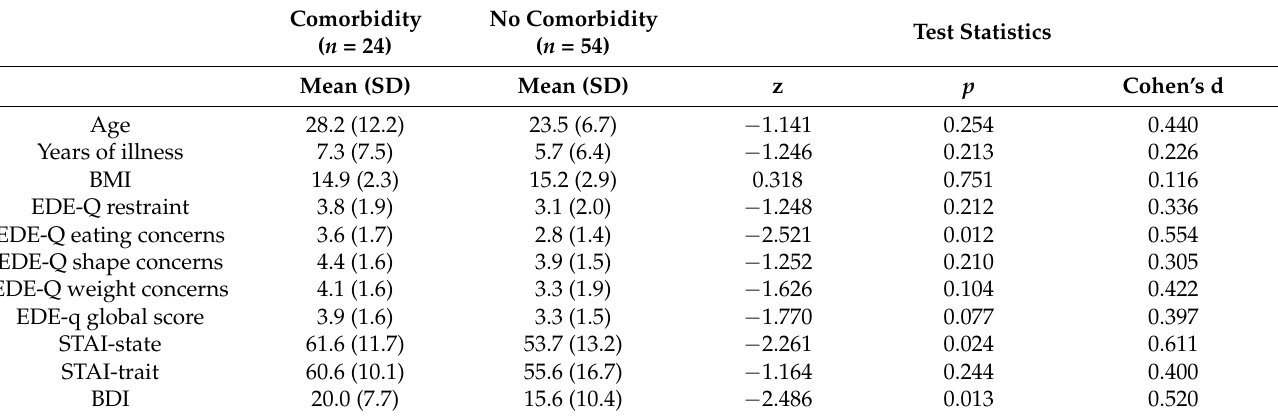
Table 3. Differences between patients with and without comorbidity according to clinical